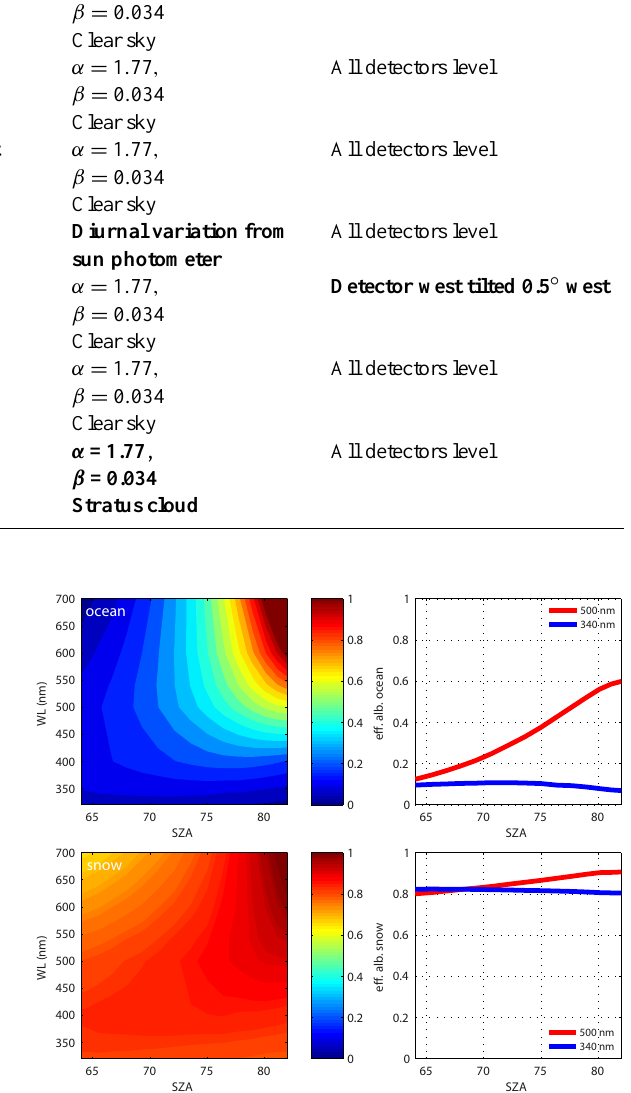
Figure 4. The effective albedo of water and snow as a function of SZA and wavelength. The right panels show slices at the two wave- lengths 340nm and 500nm. Note the strong sun glint for the ocean at high SZA and wavelength.